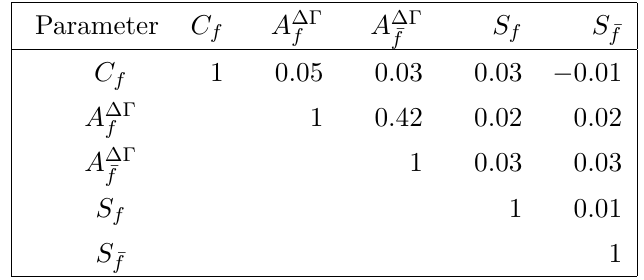
Table 6 . Correlation matrix of the total systematic uncertainties of the CP